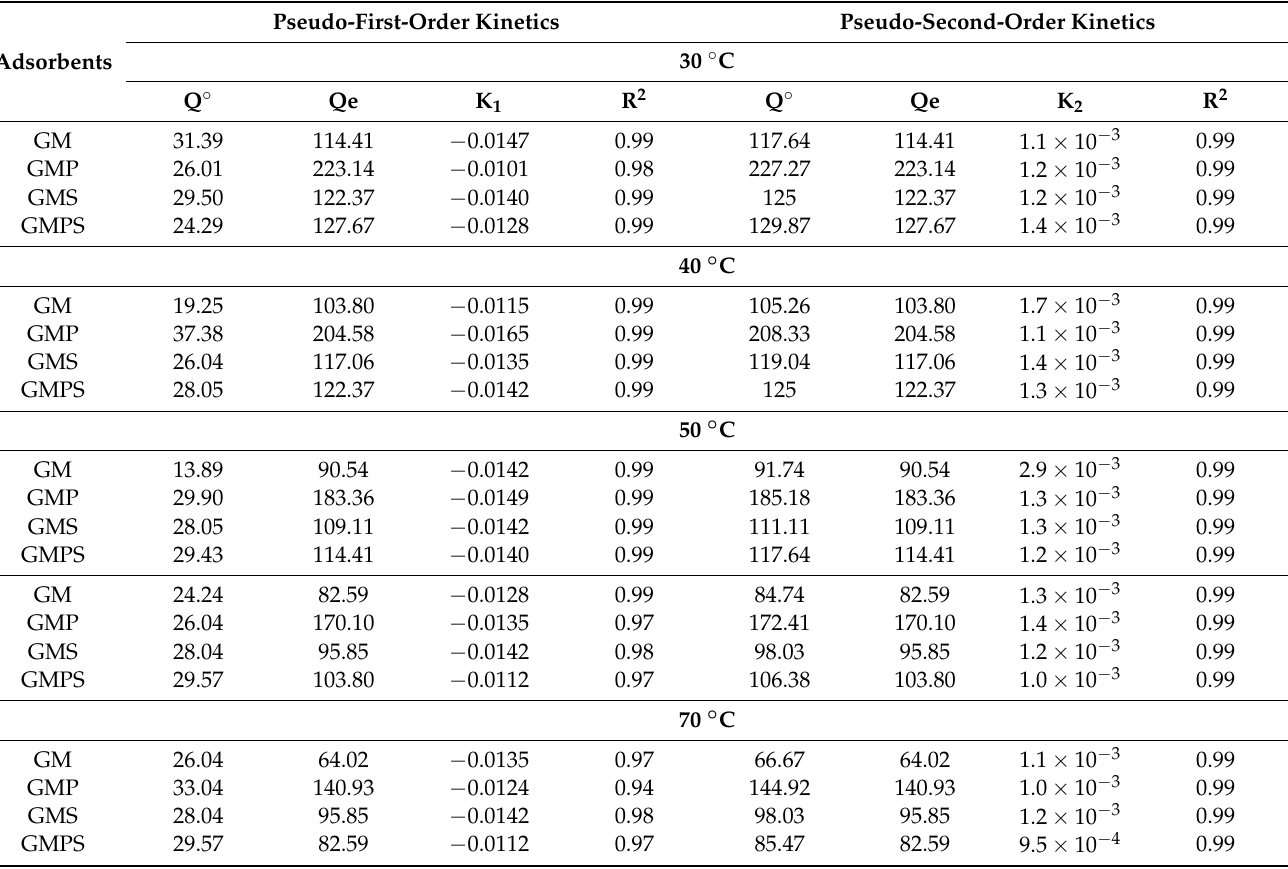
Table 6. Comparison of pseudo-first-order kinetics and pseudo-second-order kinetics for Foron red dye using golden marble waste composites at different